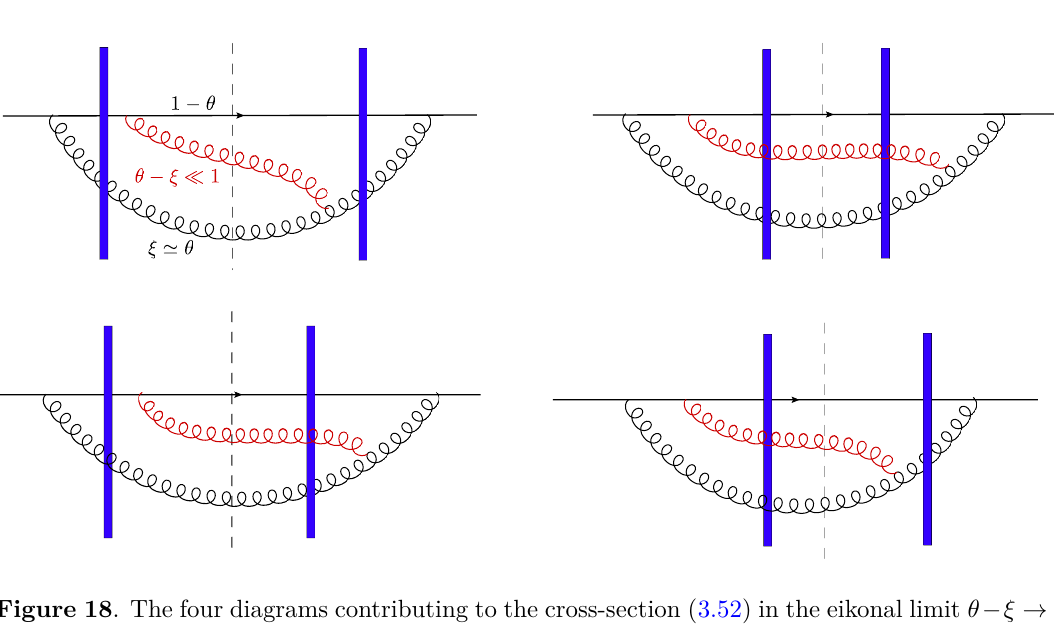
Figure 18 . The four diagrams contributing to the cross-section (3.52) in the eikonal limit θ − ξ → 0 (the soft gluon is shown in red).